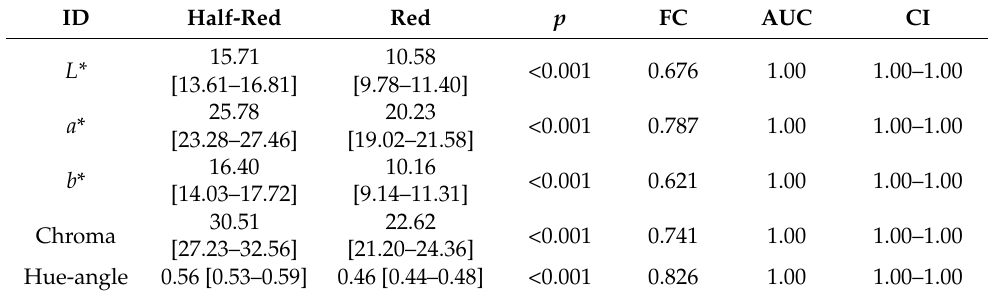
Table 2. Univariate data analysis of image data: ID indicates the feature name, in columns half-red and red the median (5th–95th) percentile is reported for the two maturity stages, p is the p -value of the factor maturity stage obtained by LME, FC is the fold change calculated as the ratio between the median of red and the median of half-red, AUC is the area under the ROC curve and CI 95% is the confidence interval of AUC at the level of 95%.